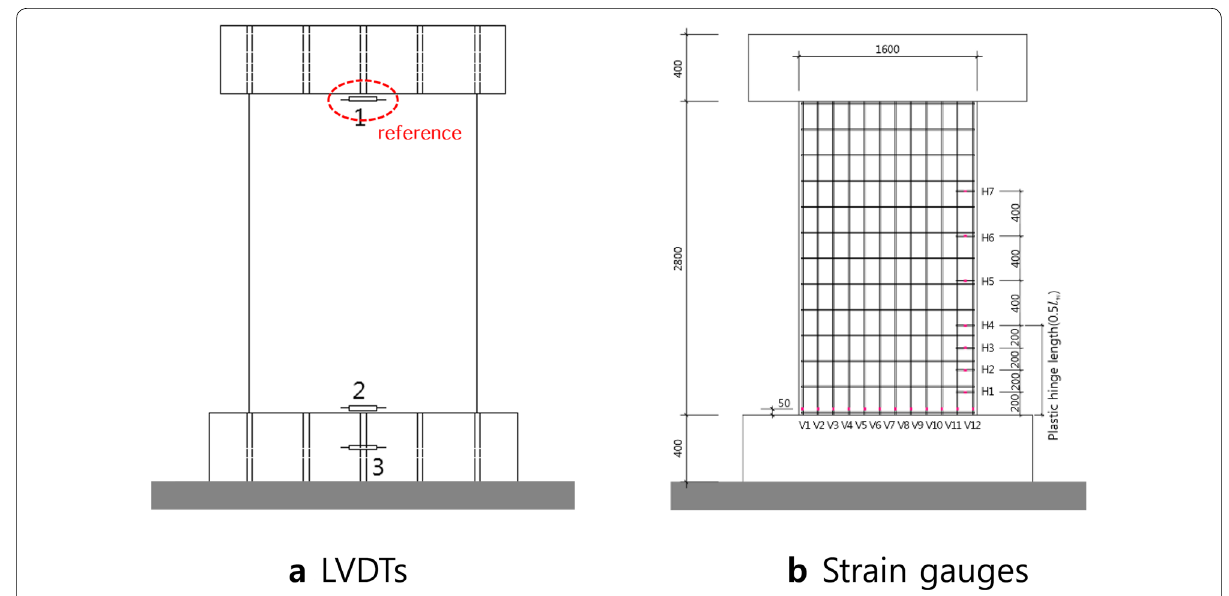
Fig. 9 Arrangement of